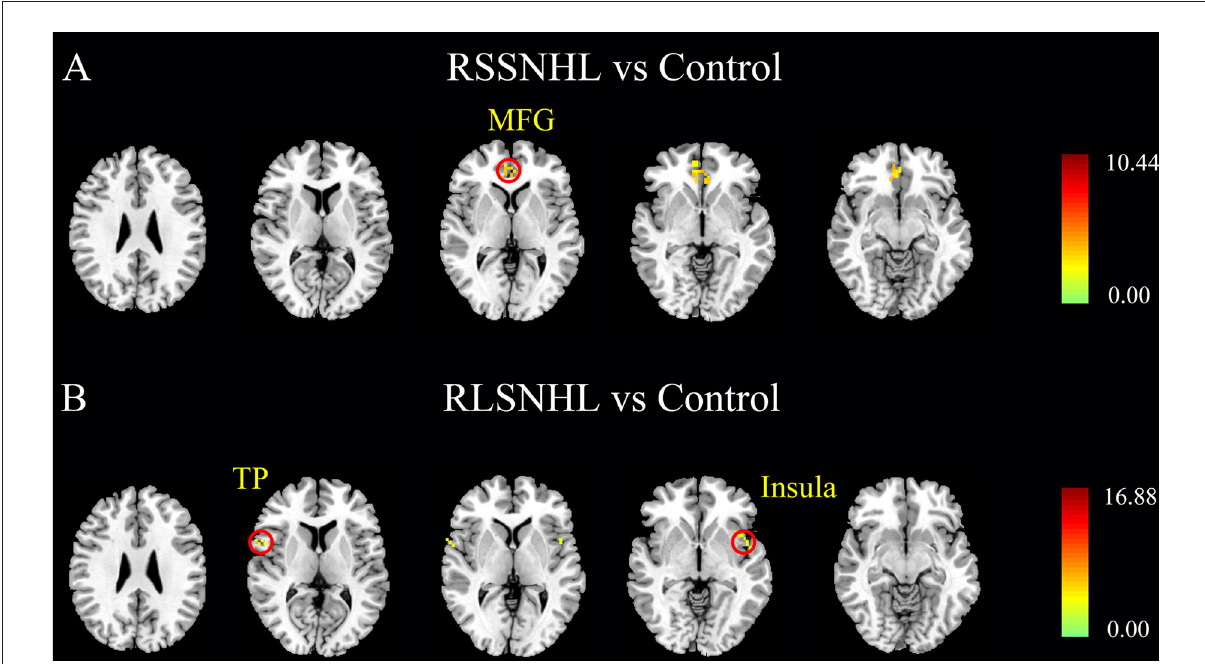
FIGURE3 Effective connectivity to the cerebellum lobule V among RSSNHL, RLSNHL, and Controls. (A) Significant regions between RSSNHL and Controls. (B) Significant regions between RLSNHL and Controls. The significant p was set at < 0.05 with family-wise error correction. The region with the significant difference among the three groups is shown with color. MFG, middle frontal gyrus; TP, temporal pole; RSSNHL, right sudden sensorineural hearing loss; RLSNHL, right long-term sensorineural hearing loss.